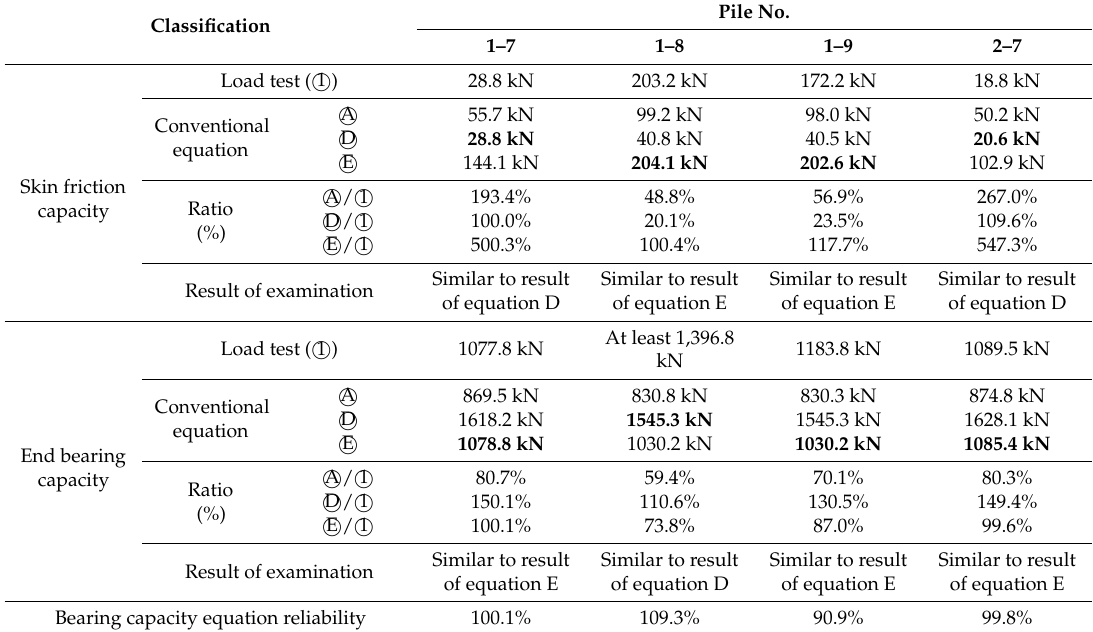
Table 9. Comparison of the end bearing capacity and skin friction capacity.